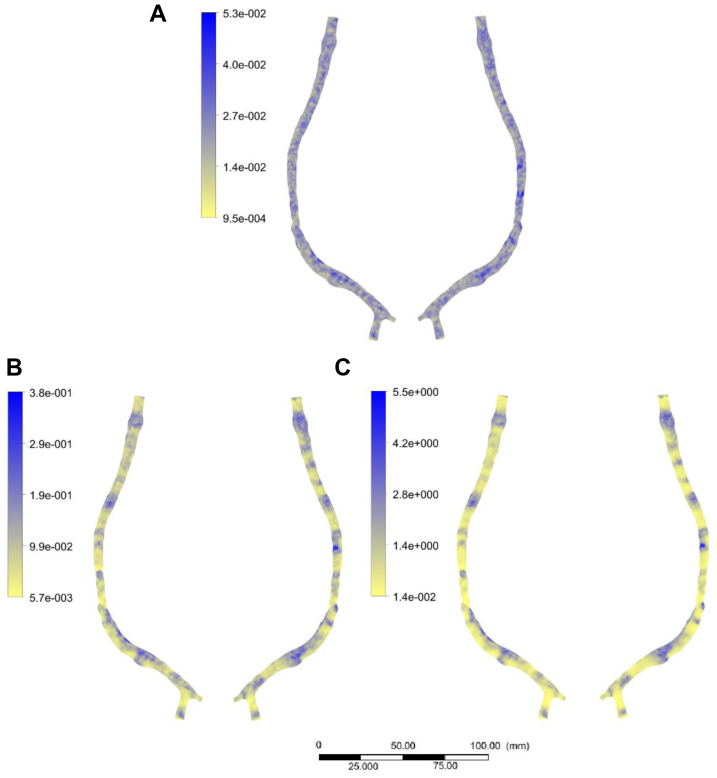
Predicted evolution of collagen per baseline value (1.67 μg/mm2) in the intimal layer of the bypass at different time points during the neointimal hyperplasia (NIH) phase (patient 3, non-newtonian case using the highly oscillatory, low magnitude shear [HOLMES] index). A, Snapshot at 146 days after intervention. B, Snapshot at 438 days after intervention. C, Snapshot at 730 days after intervention.